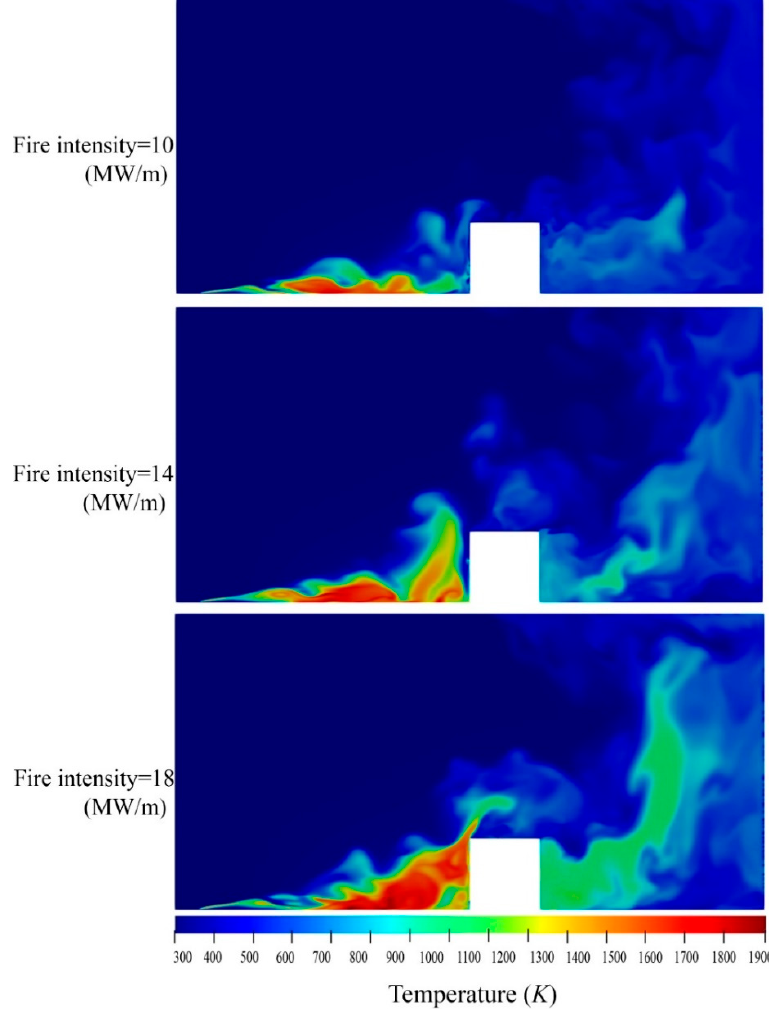
Figure 4. Temperature distribution for the reference velocity U ref = 6 m/s for various fire intensities.